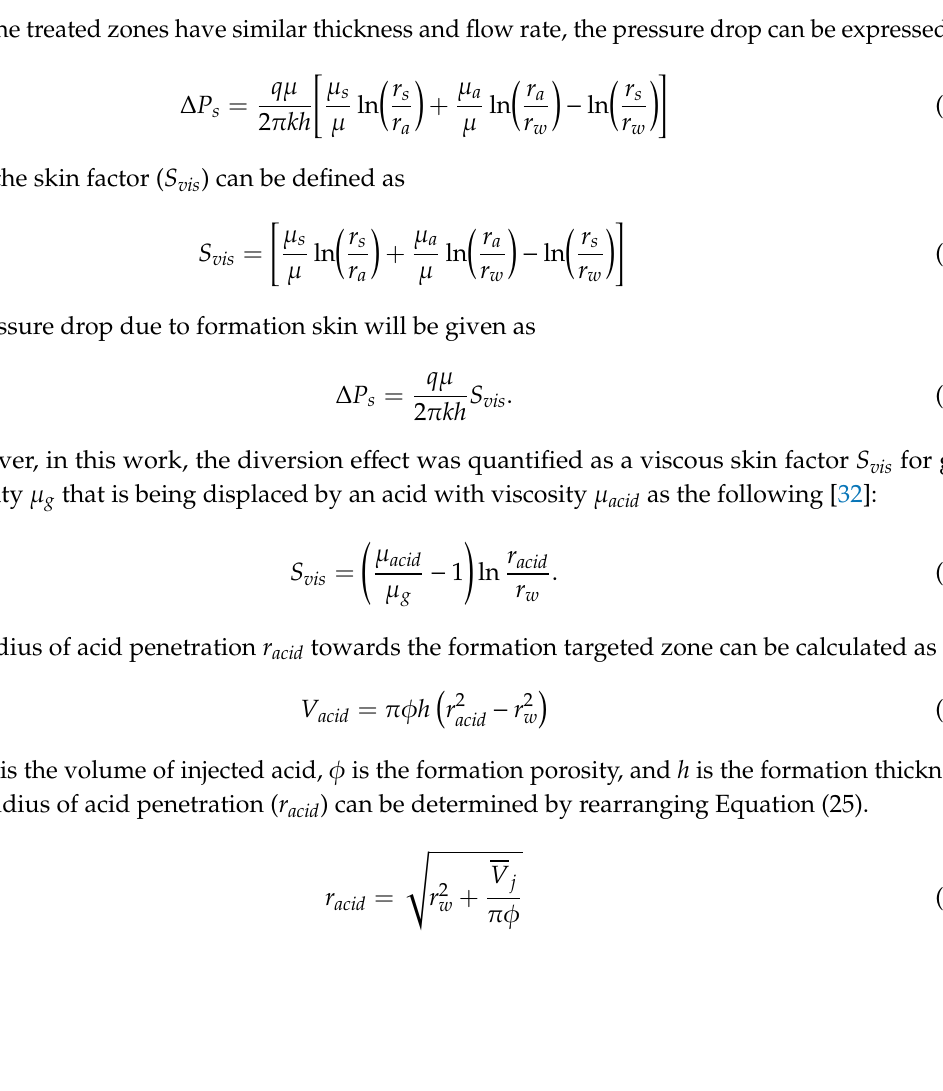
Figure 19. A schematic of the different regions around the wellbore during acidizing treatment.